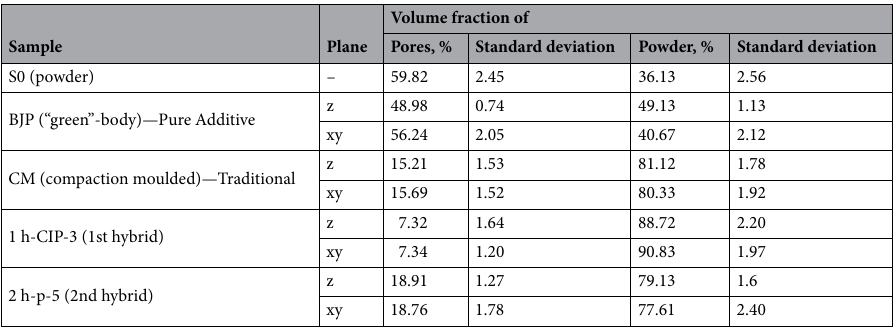
Table 1. Image analysis showing volume fraction of porosity “green”, under treated, and isostatically pressed